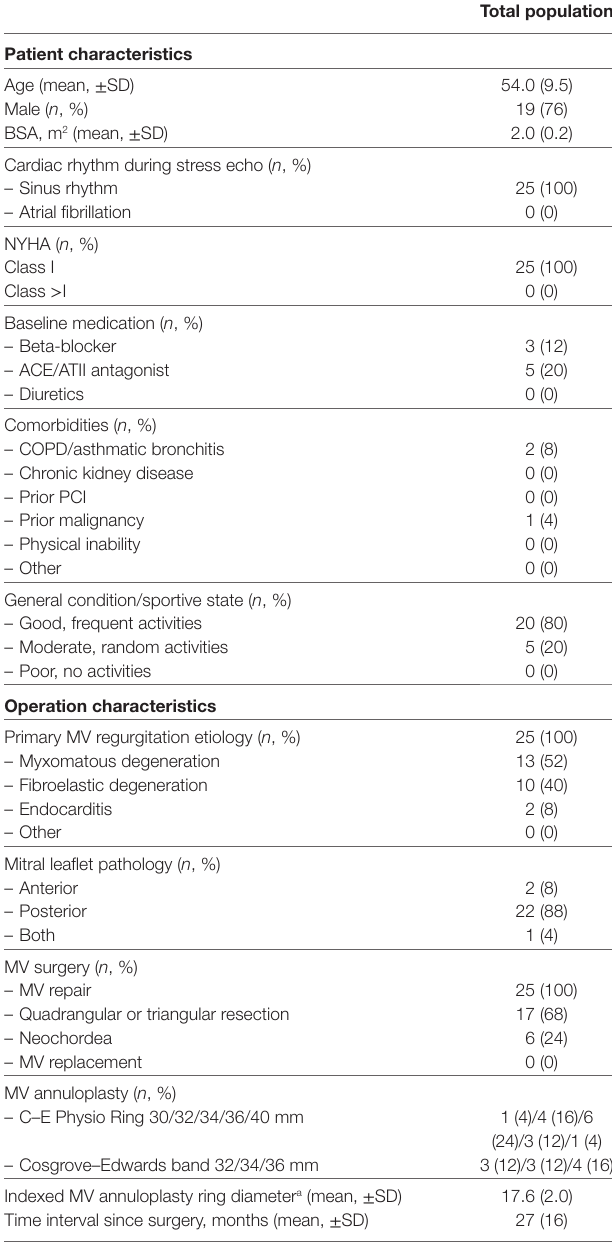
TaBle 1 | Baseline characteristics ( n =